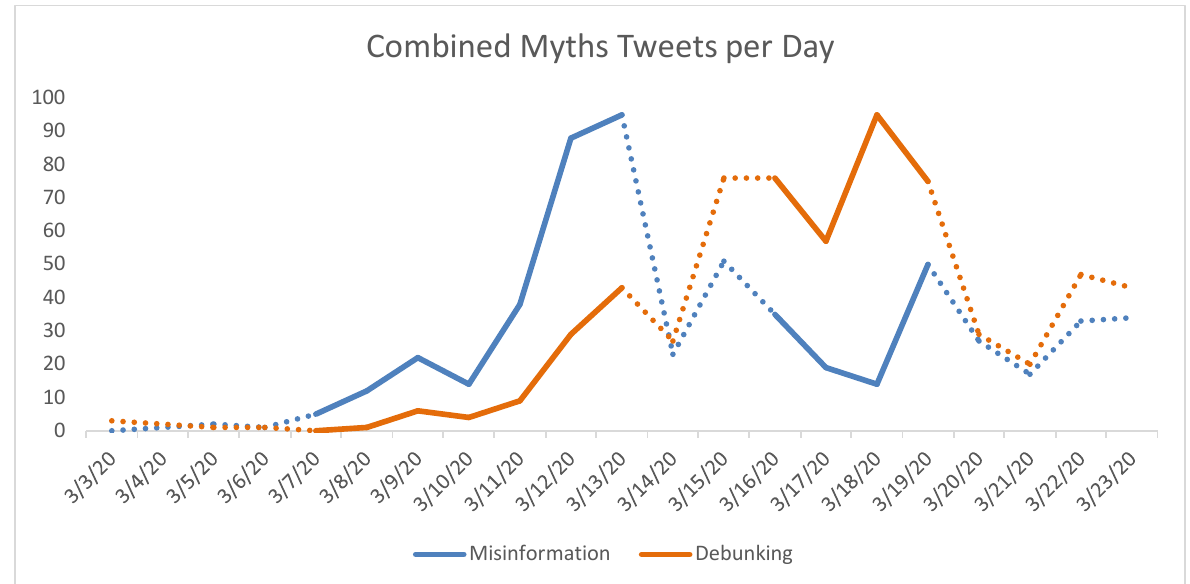
Figure 2. COVID-19 gargle myth and hold breath myth aggregate totals of misinformation tweets vs. debunking tweets over time. The solid line indicates the days when the difference in proportion between misinformation and debunking tweets was significant (p < .05) according to a Chi-square Test for Independence. The dotted line indicates the days when the proportion of the two types of tweets did not differ significantly.